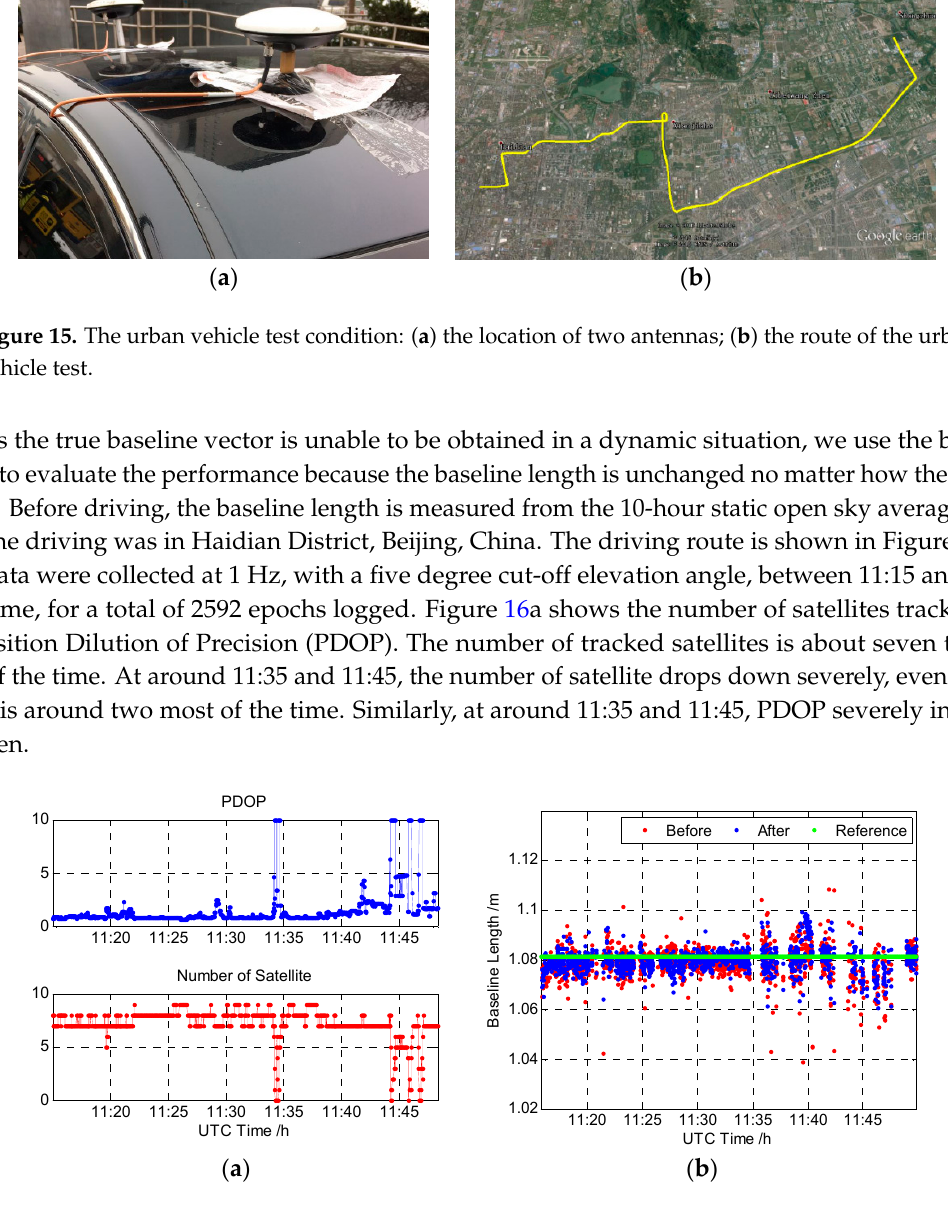
Figure 16. The urban vehicle test result: ( a ) the Position Dilution of Precision (PDOP) and the total satellite number; ( b ) the baseline length of the urban vehicle test.